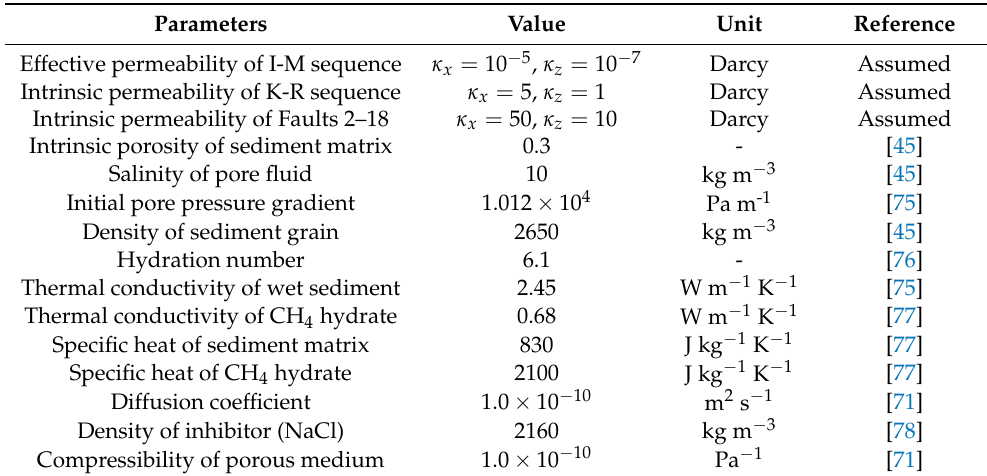
Table 2. Hydrothermal properties of the permafrost and GH-bearing sediments as well as other parameters used in the present